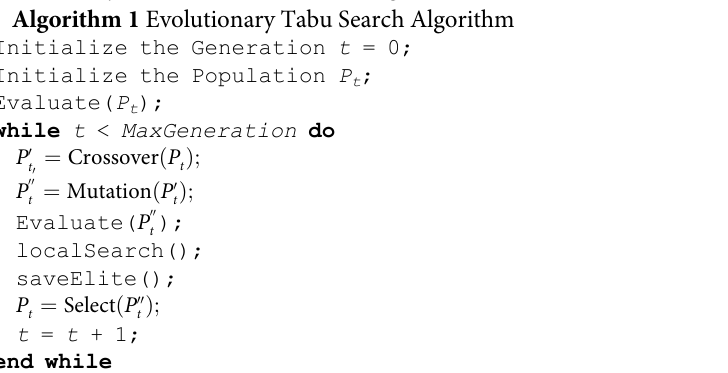
Algorithm 1 Evolutionary Tabu Search